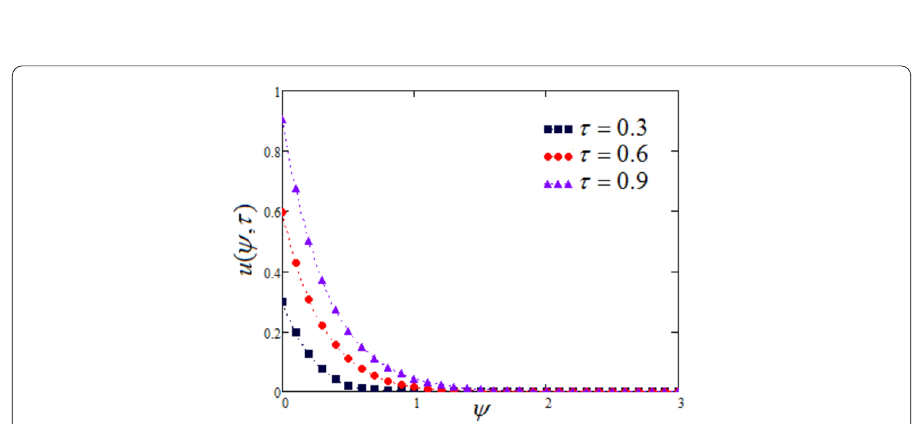
Figure 11 Velocity profile of a Maxwell fluid for various values of τ